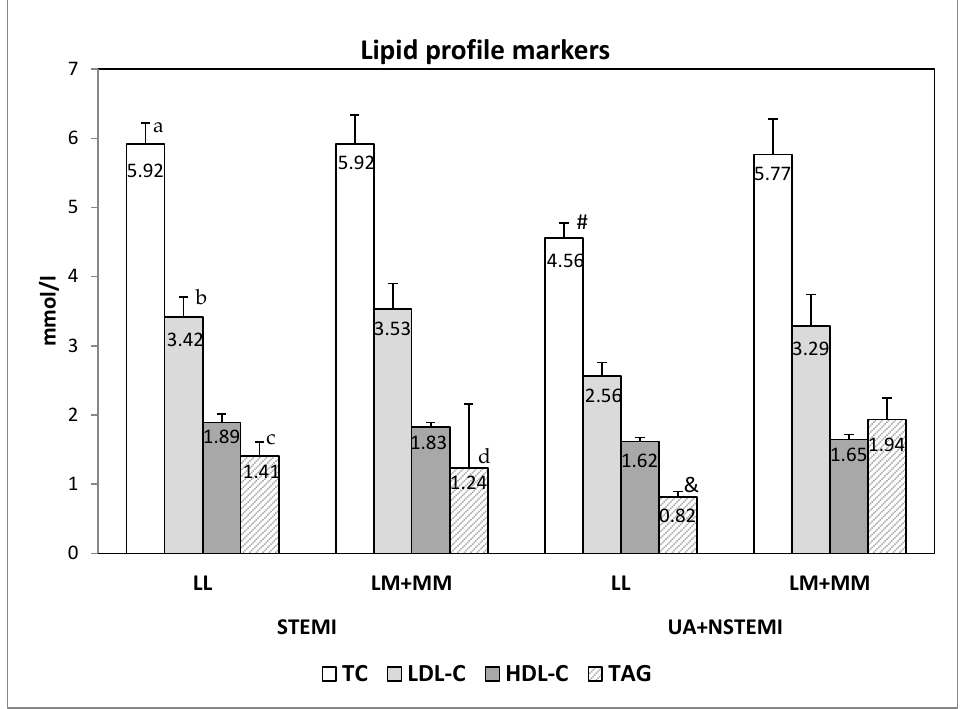
Commented [M2]: 2 Figure 2. The serum lipid profile markers in patients with different PON1 L55M genotypes and